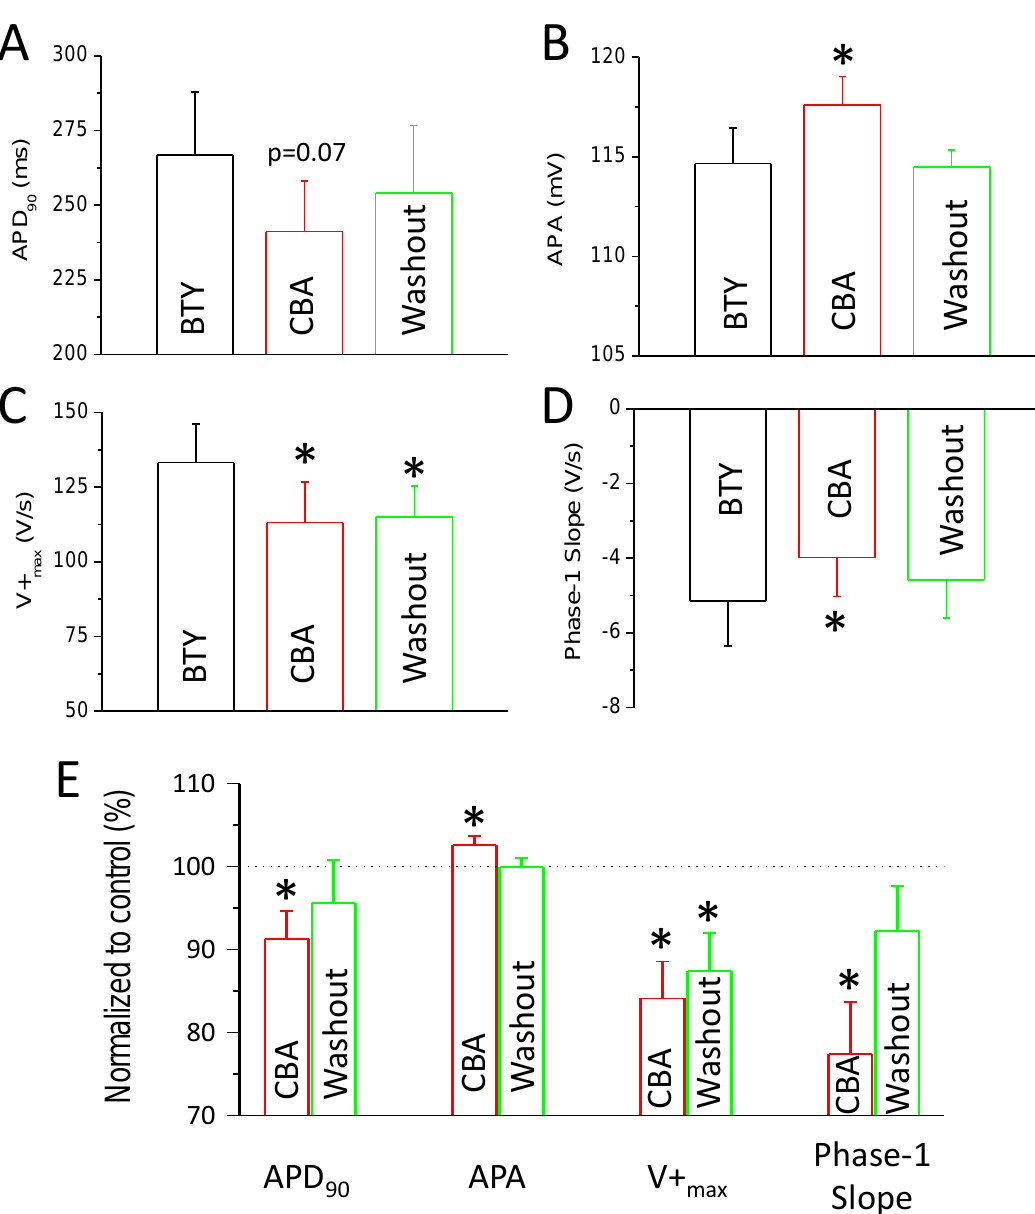
Figure 3. Action potential parameters affected by CBA. Diagrams showing AP parameters in control conditions (black), in the presence of CBA (10 µ M, red), and after washout of CBA (green). ( A ) Average ± SEM values of action potential duration measured at 90% of repolarization (APD 90 ). ( B ) Average ± SEM values of action potential amplitude (APA). ( C ) Average ± SEM values of maximal rate of depolarization (V + max ). ( D ) Average ± SEM values of maximal rate of early repolarization (phase-1 slope). ( E ) Average ± SEM values of the same four parameters normalized to control conditions in the presence (red columns) and after washout of CBA (green columns). All parameters were recorded in eight cells obtained from six animals. Asterisks show statistically significant differences compared to